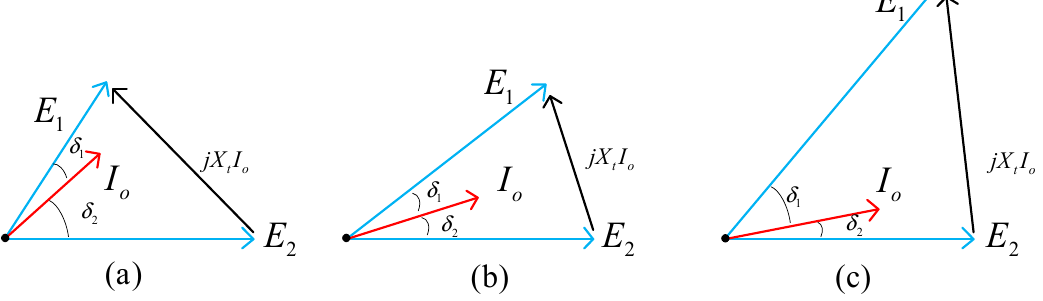
Figure 4. Phasor diagram of E 1 , E 2 and I o for di ff erent voltage ratio conditions in forward power transfer.